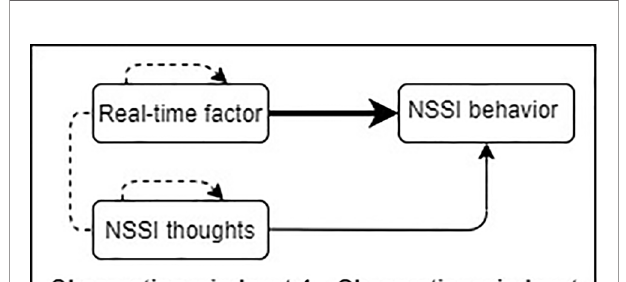
negative affect, positive affect, and self-ef fi cacy to resist NSSI), beyond NSSI thoughts at the within-person level. Solid arrows indicate effects of interest. Dotted arrows represent autoregressive effects and dotted lines associations within the same